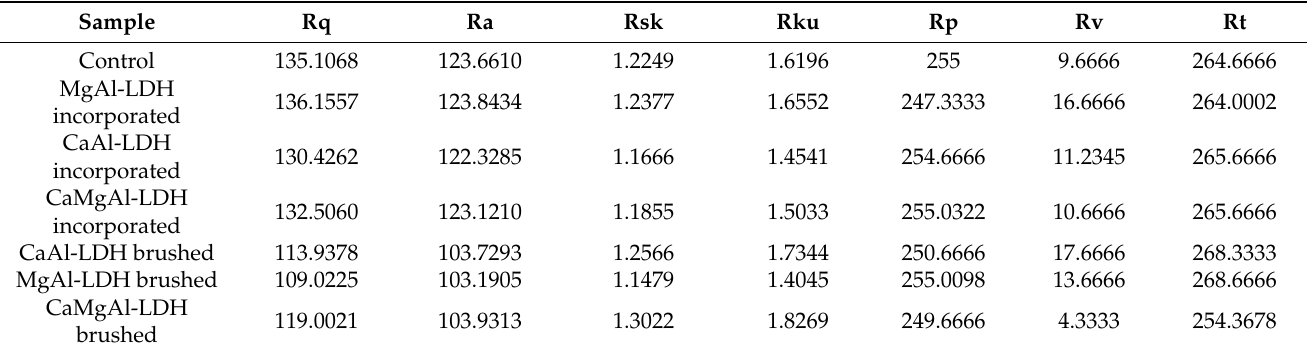
Table 8. Roughness parameters and pore surface area for the treated and control model samples.